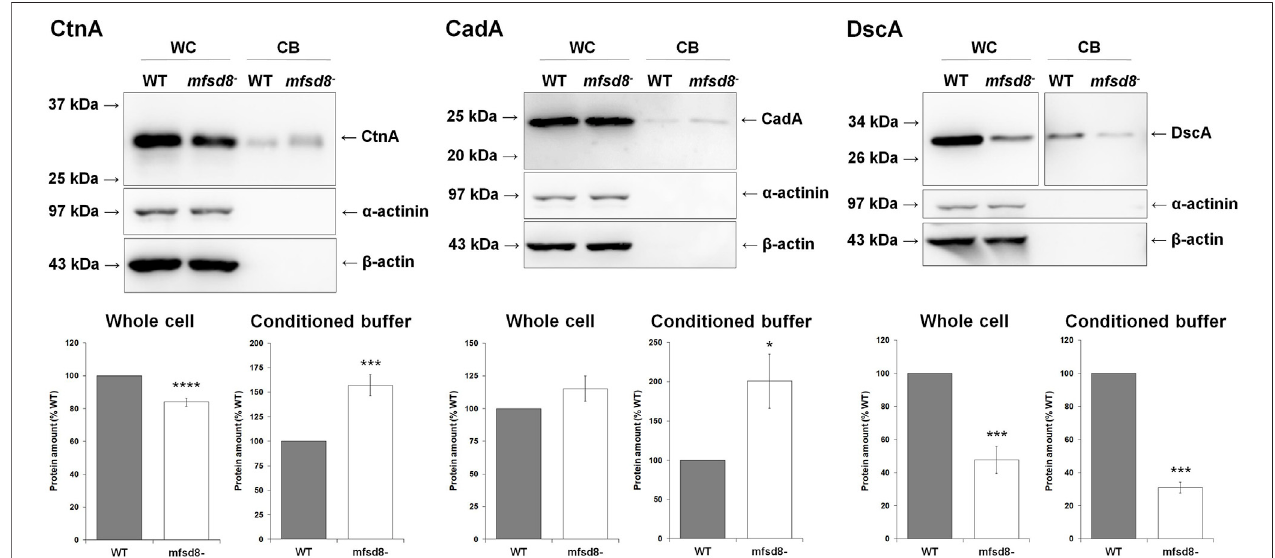
FIGURE 8 | Effect of mfsd8 -de fi ciency on the intracellular and extracellular levels of CtnA, CadA, and DscA. Cells grown axenically in HL5 were starved for 4 h in KK2 buffer, after which time whole cell (WC) lysates and conditioned buffer (CB) were collected. WC lysates (15 μ g) and concentrated CB (0.25 μ g) were separated by SDS-PAGE and analyzed by western blotting with anti-CtnA, anti-CadA, anti-DscA, anti- α -actinin (loading and fractionation control), and anti- β -actin (loading and fractionation control). Protein bands from WC lysates were standardized against the levels of α -actinin and β -actin. Data presented as mean protein amount (% WT) ± SEM ( n = 8). Statistical signi fi cance was assessed using the one sample t -test. * p < 0.05, *** p < 0.001, and **** p < 0.0001 vs. WT.